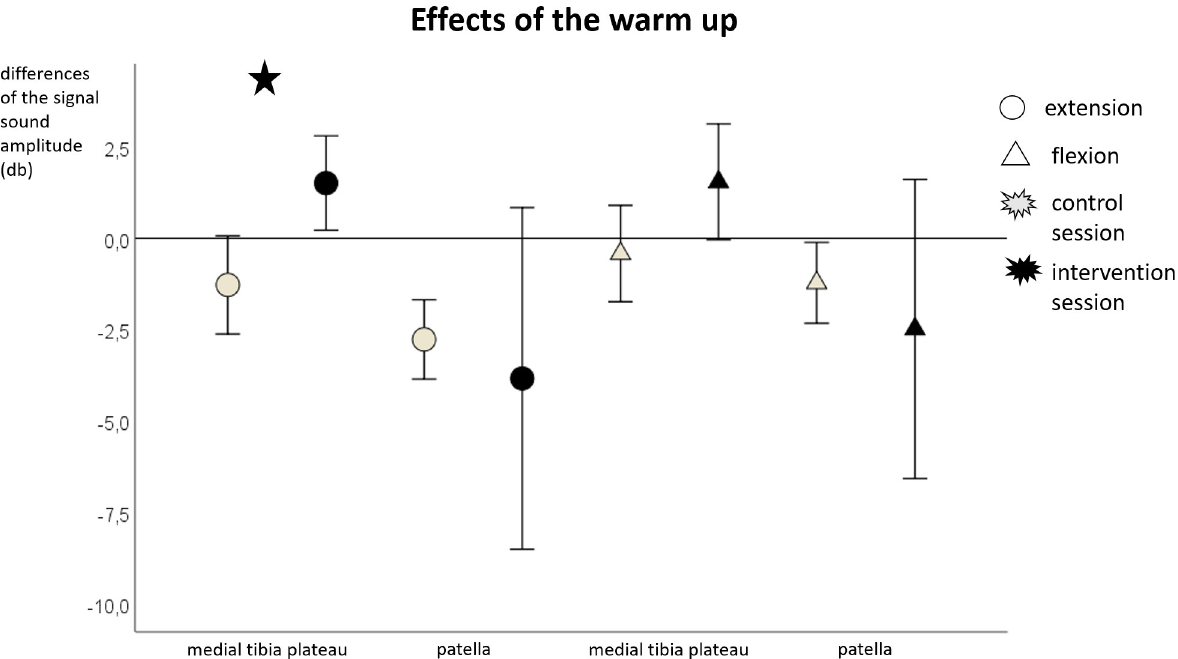
Fig 3. Mean and 95% confidence interval values of the pre-post differences of the mean sound amplitude during extension) and flexion) for the warm-up. The asterisks mark significant differences between the control and intervention sessions.